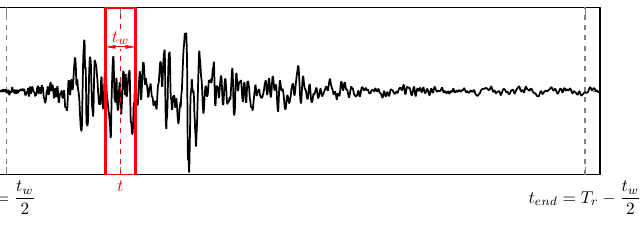
Figure 1. Parameter extraction from a record of the Northridge earthquake in 1994 [35] using a moving time